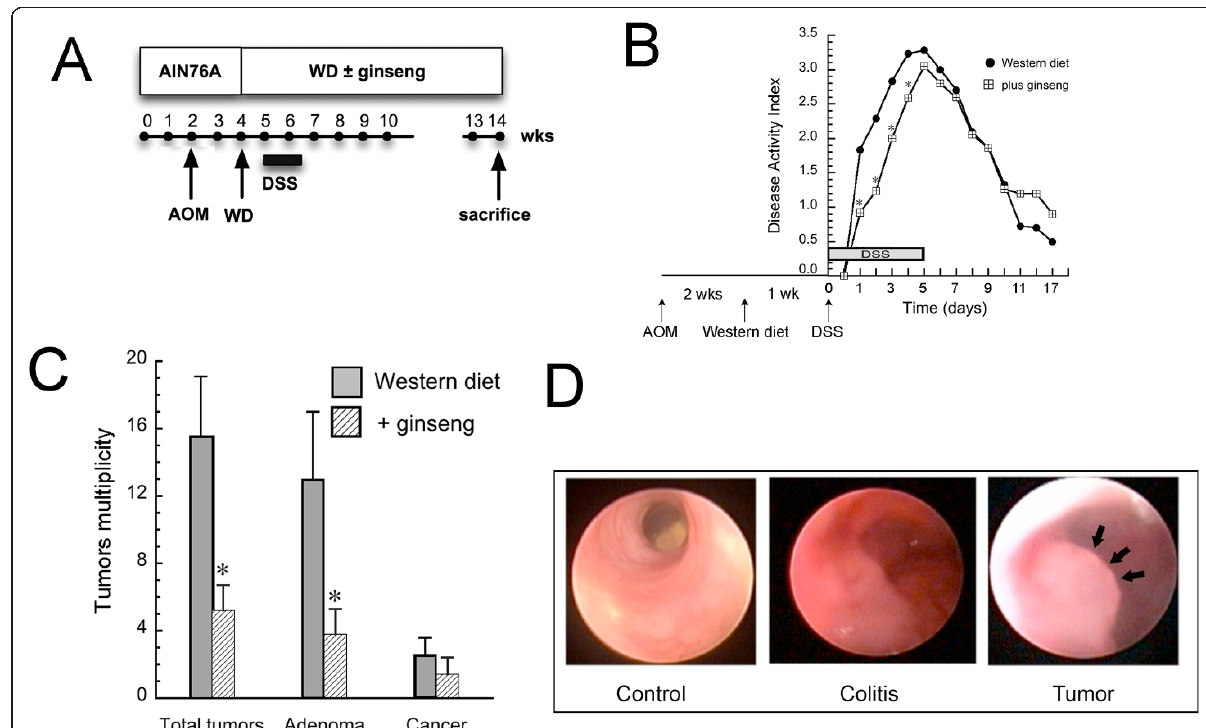
Figure 1 Ginseng inhibits colitis and colonic tumorigenesis in mice on Western diet . A . Protocol for tumor induction. Mice received AOM at wk 2. WD was initiated at wk 4 and DSS was given beginning in wk 5. Mice were sacrificed in wk 14. B . Time course of DSS colitis. Animals were treated as shown in Figure 1A. DSS induced colitis was scored as disease activity index (DAI) based on weight loss, diarrhea and bleeding as described [38]. Values were expressed as mean ± SD (n = 7 AOM/DSS, n = 5 AOM/DSS + ginseng; *p < 0.05, compared to Western diet alone). Ginseng significantly delayed onset of colitis and appeared to limit peak inflammation. C . Tumor multiplicity. Mice were treated as described in Figure. 1A and sacrificed 12 wks after AOM. Tumor histology was determined by standard criteria. Tumor multiplicity was calculated using the Wilcoxon-Mann-Whitney test (n = 7 AOM/DSS, n = 5 AOM/DSS + ginseng; *p < 0.05 compared to AOM/DSS alone). Note that ginseng significantly inhibited total tumor multiplicity and the number of adenomas/mouse. D . Colonoscopy detects colitis and tumors. Shown are representative colonoscopic views of control mice ( left panel ), mice with colitis 5 days after DSS ( middle panel ) and mice with tumors 12 wks after AOM ( right panel ). Note the increased mucosal erythema in the colitis-bearing mouse and intraluminal mass in the tumor-bearing mouse (black